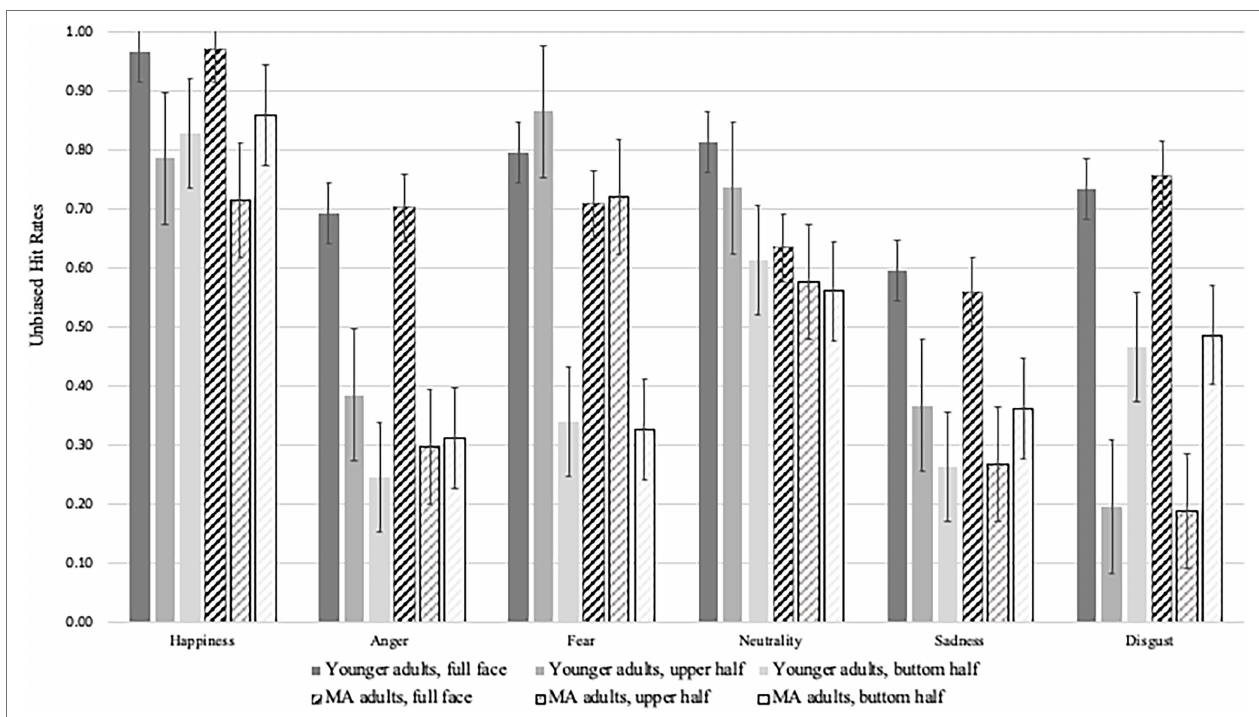
FIGURE 2 | Emotion recognition performance per emotion, face section and age